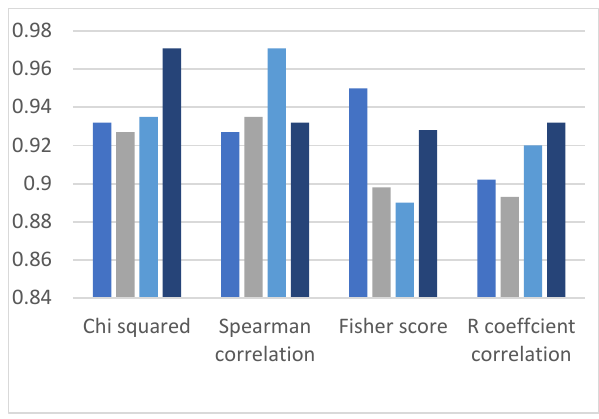
Figure 10. Precision using enhanced NN.